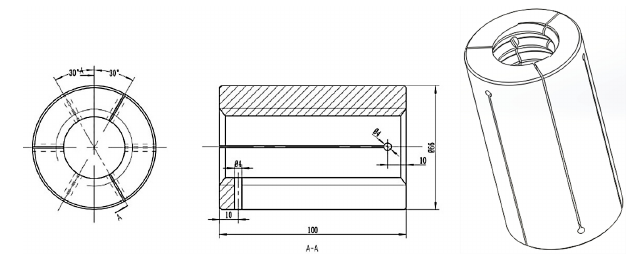
Figure 3. Detail drawing of the lapping nut.